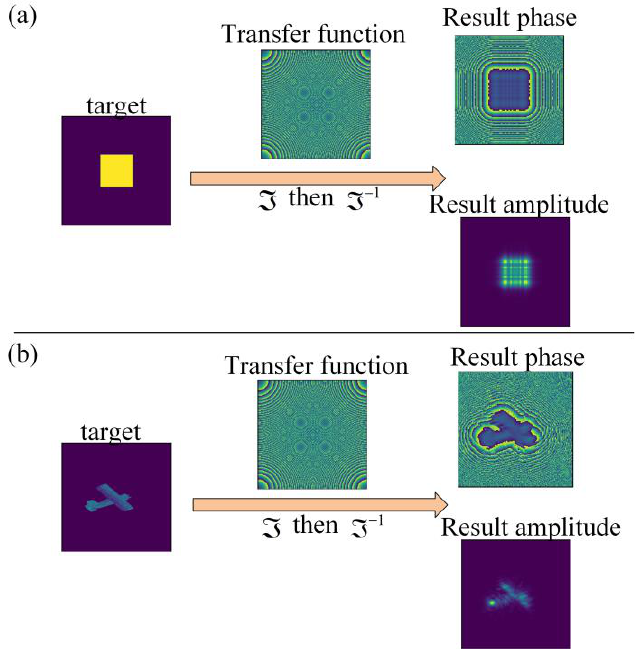
Figure 3. Diffraction simulation display. ( a ) Diffraction of square. ( b ) Diffraction of real target from da- taset.